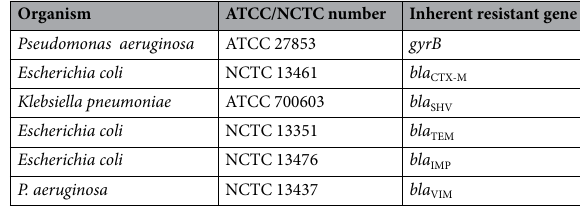
Table 4. Control strains used for rPCR